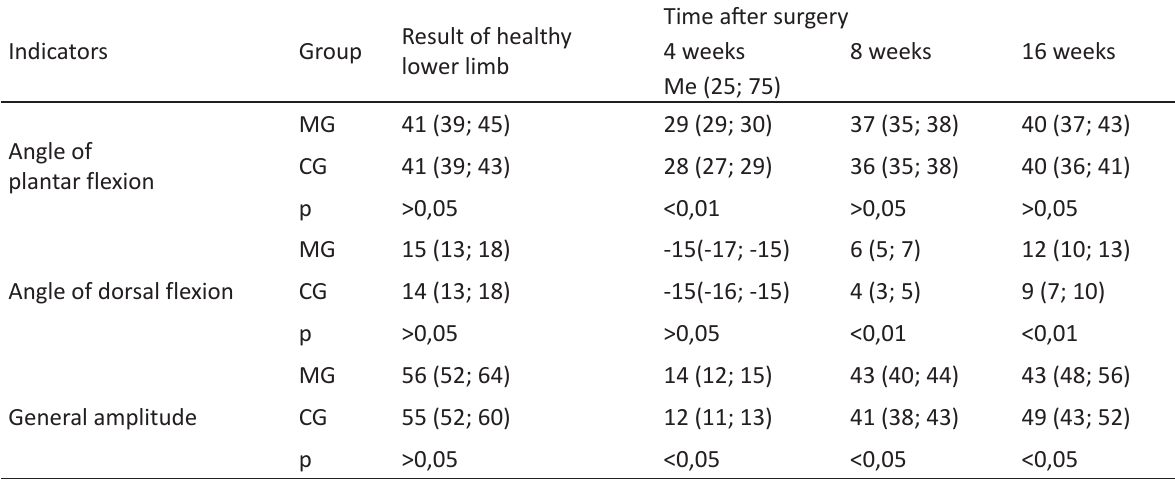
Table 1. Statistical indices of goniometry in the dynamics of restorative treatment, degrees